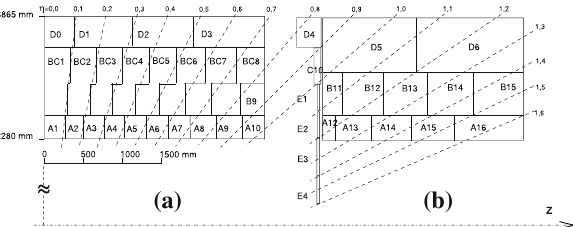
Fig. 4 The cell structure in the right half the long barrel ( a ) and extended-barrel ( b ) module of the calorimeter. The left half of the long barrel is not shown as the long barrel is symmetrical. Solid lines show the cell boundaries formed by grouping optical fibers from the tiles for read out by separate PMTs. The dashed lines represent fixed pseudo- rapidity values